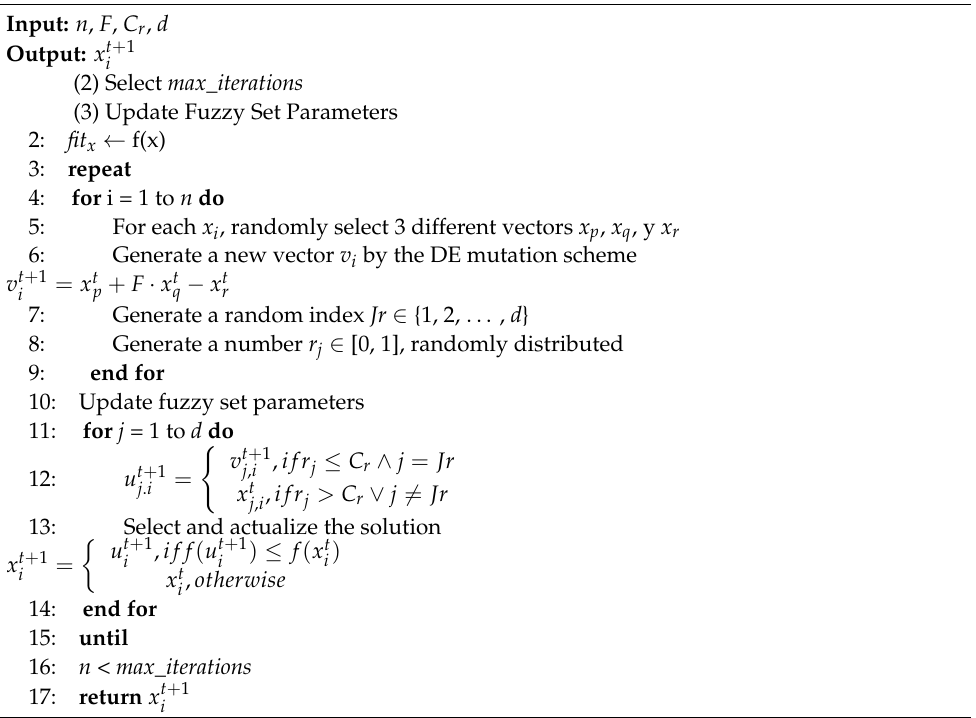
Algorithm 2 Differential evolution algorithm